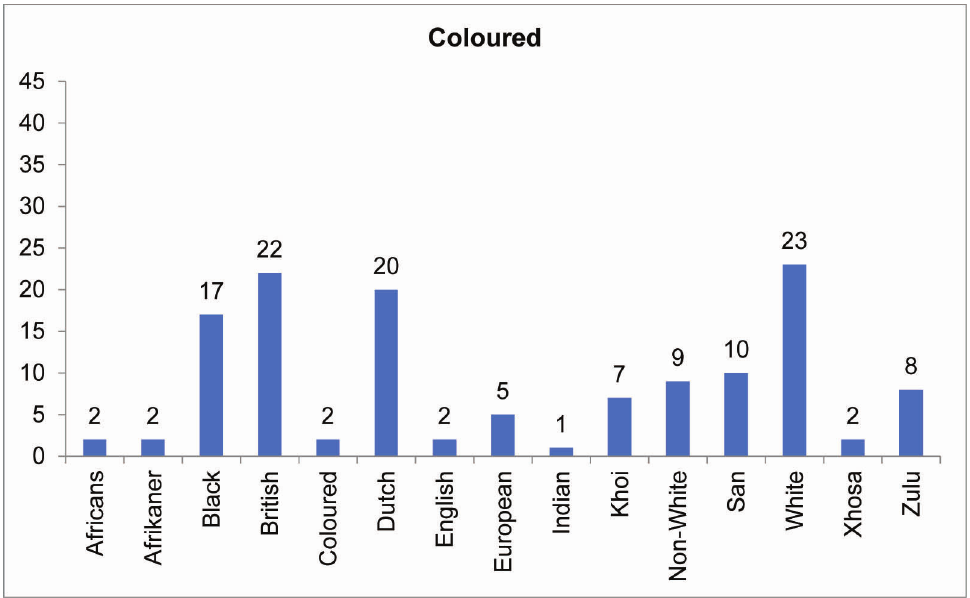
Figure 6:  Races/ethnic groups mentioned more than ten times in coloured students’